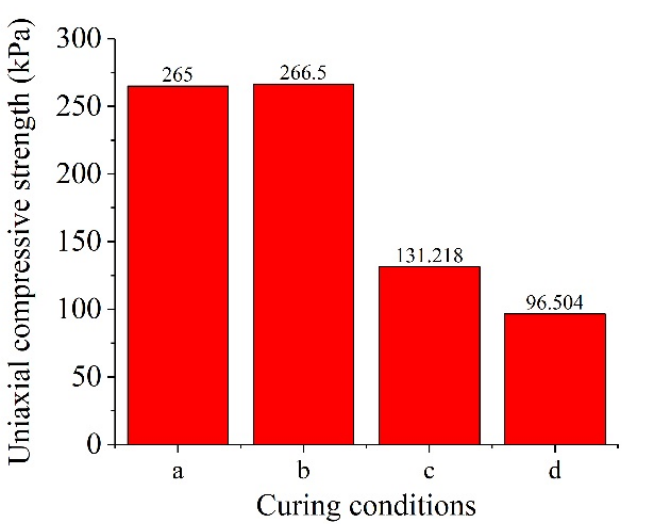
Figure 8. The uniaxial compressive strength statistics of materials, where a is natural curing for 20 days, b is curing under 400 W microwave conditions for 500 min, c is curing under 1200 W microwave conditions for 300 s, and d is curing under 2000 W microwave conditions for 200 s.